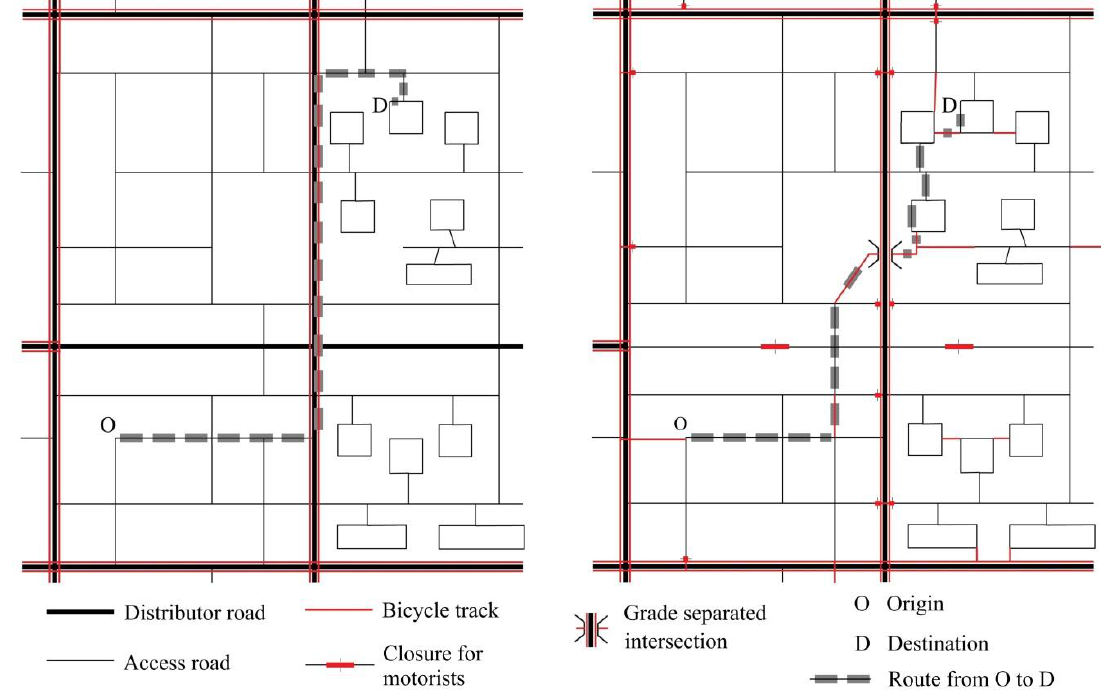
Figure 1. Examples of unbundling for two cycle routes; the degree of separation is low for the route in the left-hand figure and high for the route in the right-hand